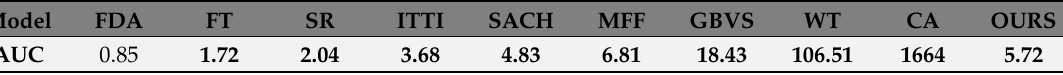
Table 3. Running time comparisons for 10